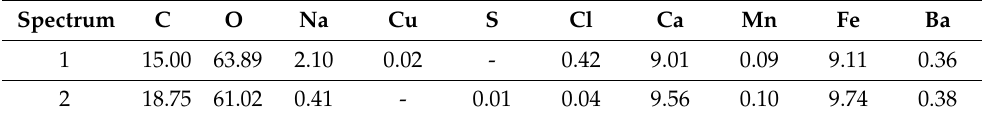
Figure 11c is the enlarged SEM image of the area in the black box marked in Figure